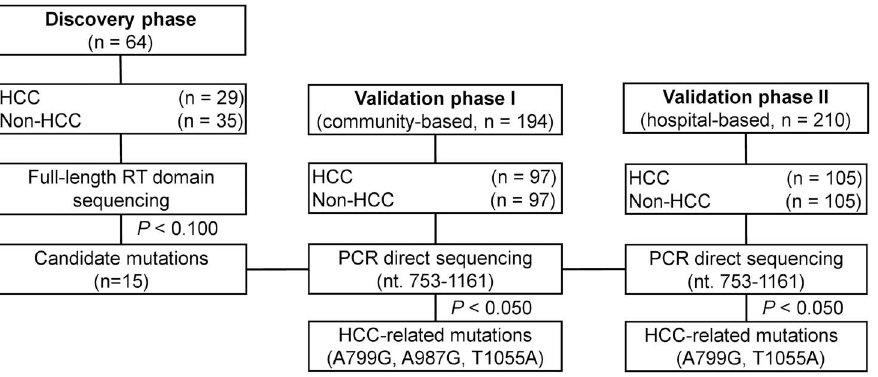
Figure 1. Study design. Abbreviations: HCC, hepatocellular carcinoma; PCR, polymerase chain reaction; RT, reverse transcriptase.